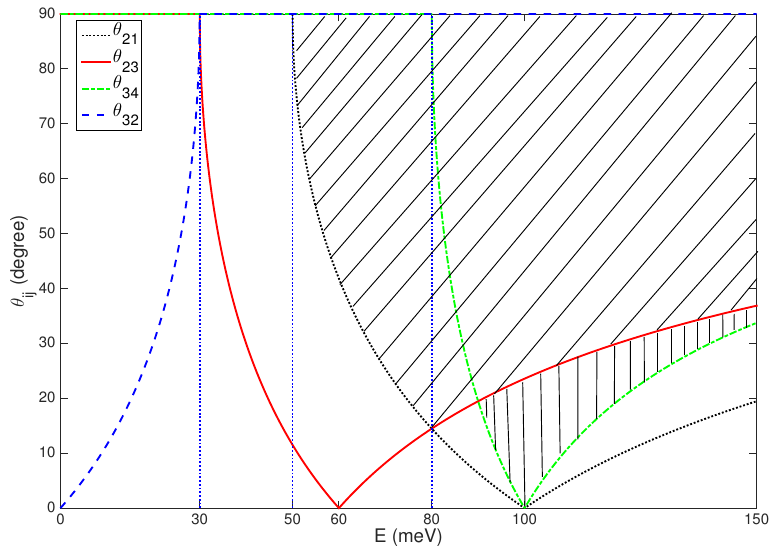
Figure 2. The critical angle θ ij as a function of the incidence energy E . The physical parameters are: V 1 = V 4 = 100 meV, V 2 = 0 meV, V 3 = 60 meV, h 1 = 100 nm, h 2 = 80